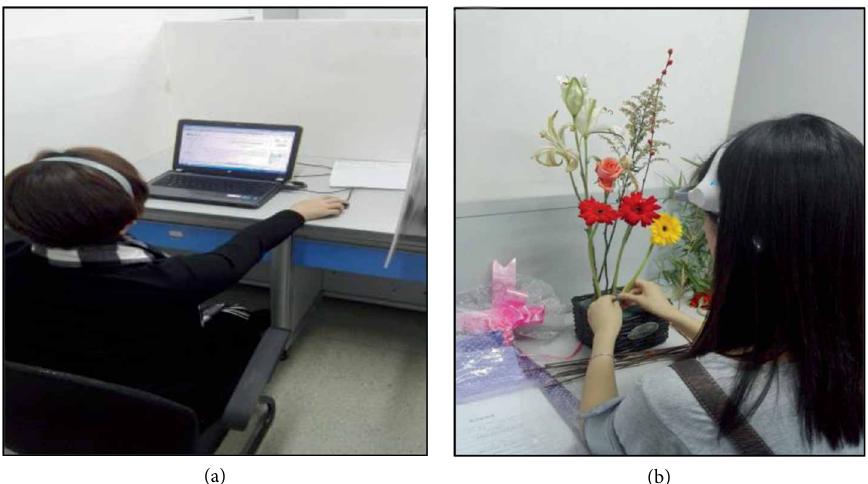
Figure 1: Photographs of experiments (a) a subject doing control activity (b) a subject doing horticultural